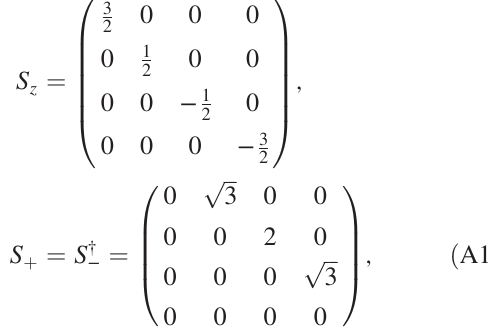
M , demonstrating that ab (not shown) transform as a M